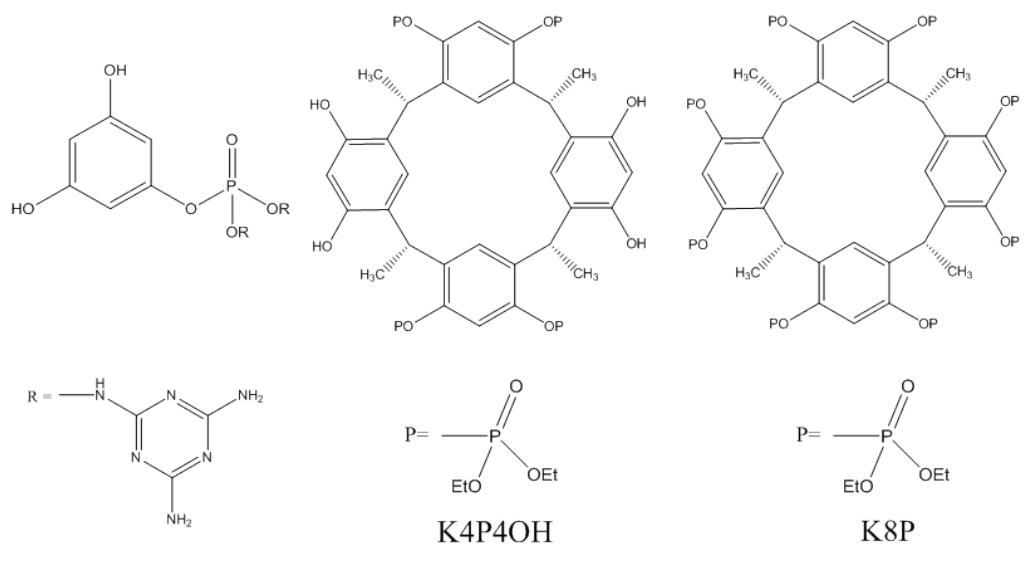
Figure 7. Monophosphorylated phloroglucinol (left), partially (K4P4OH, middle) and fully (K8P, right) phosphorylated C-methylcalix [4] resorcinarene